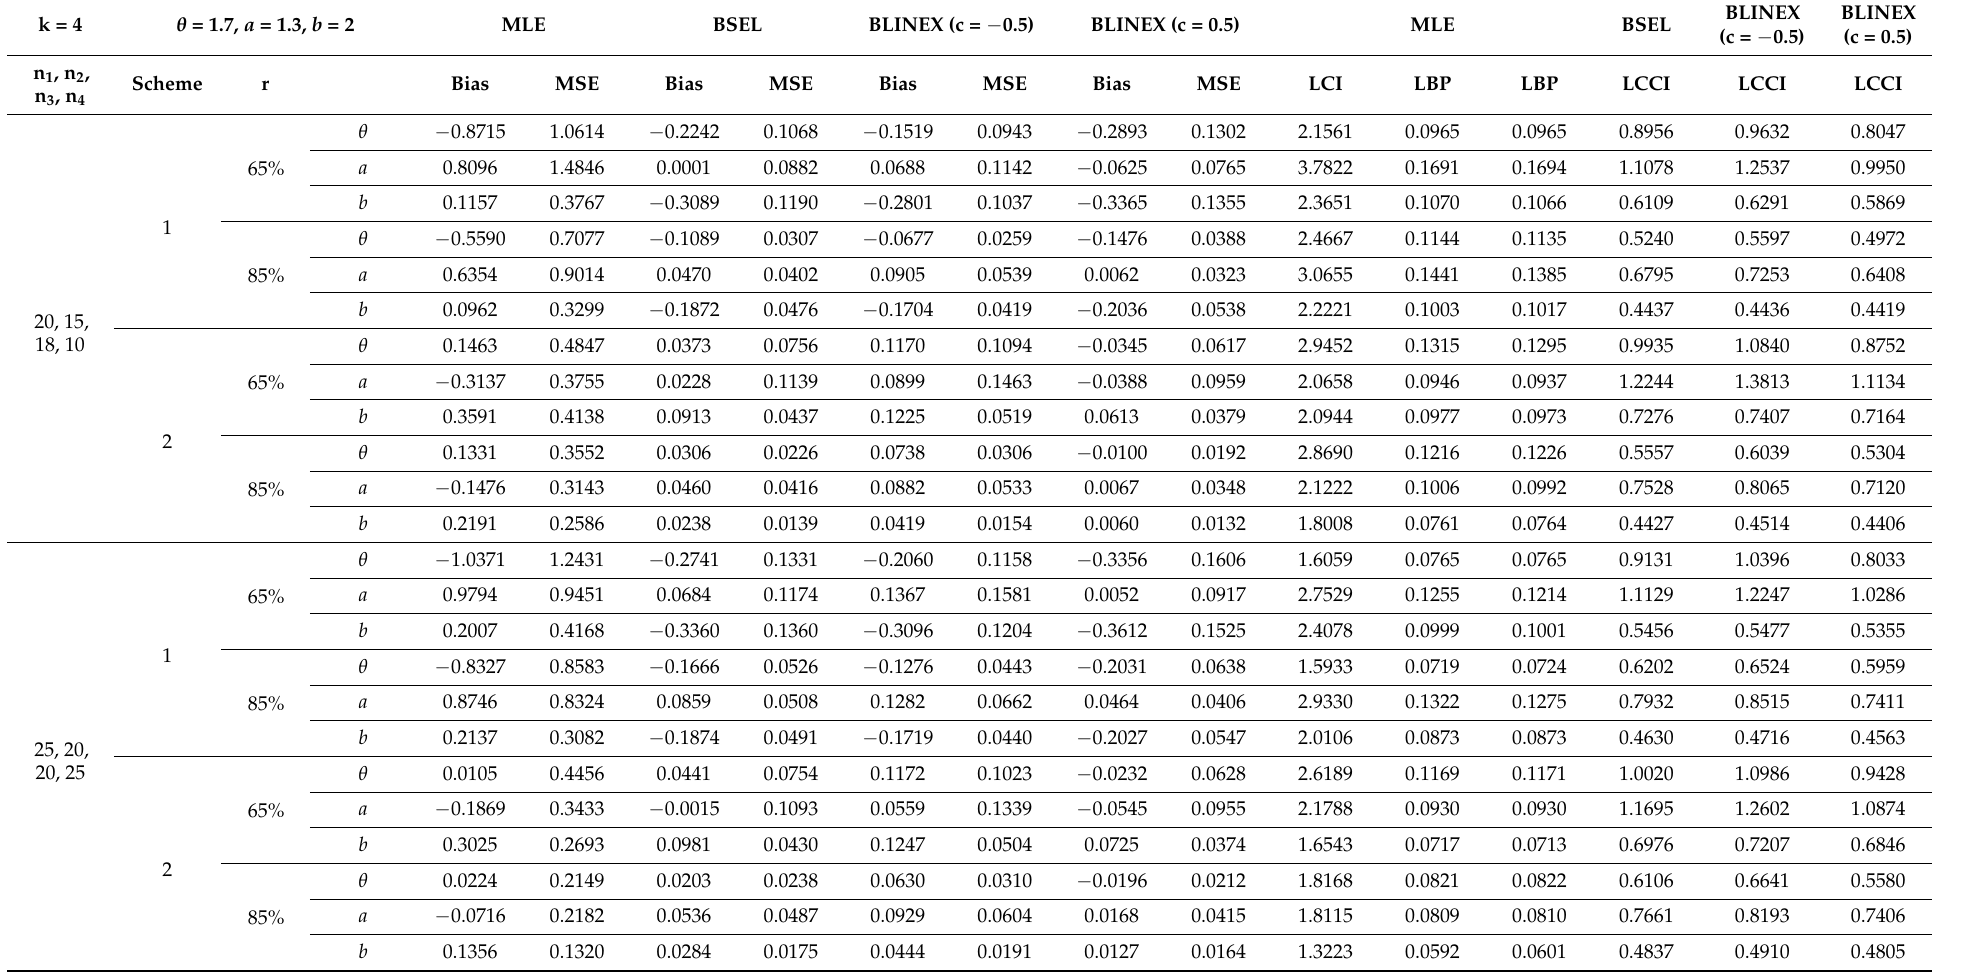
Table 4. MLE and Bayesian estimation with different loss functions in multi ramp when θ = 1.7, a = 1.3, b =